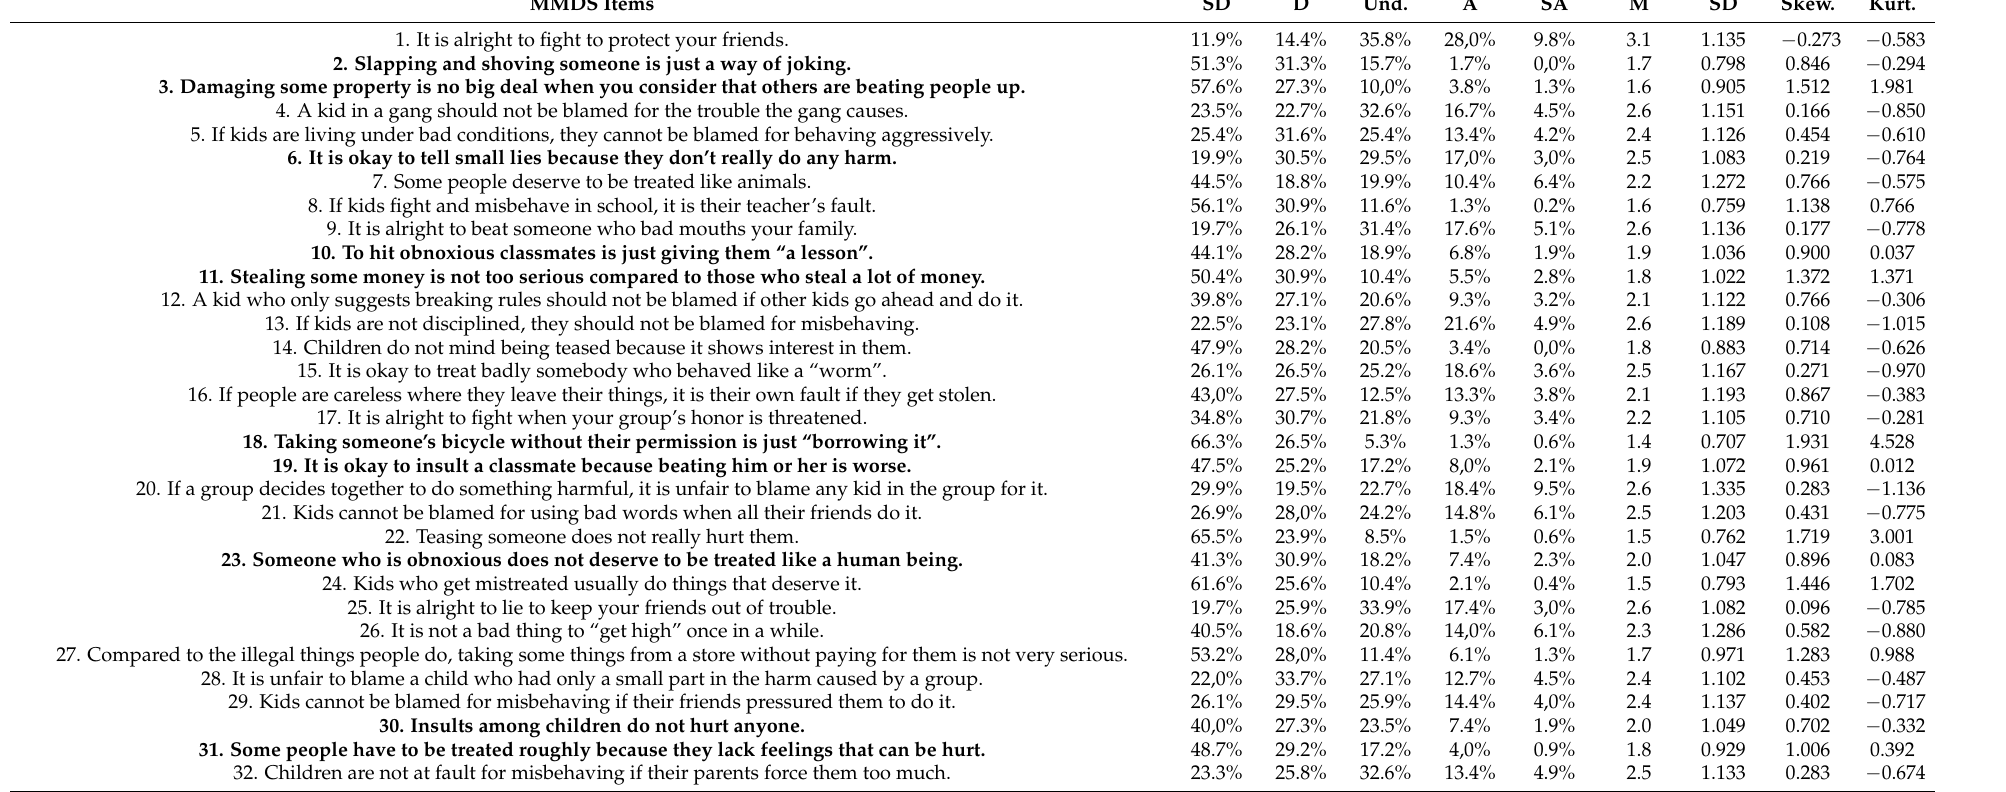
Table 4. Percentages of the response options and descriptives of the MMDS